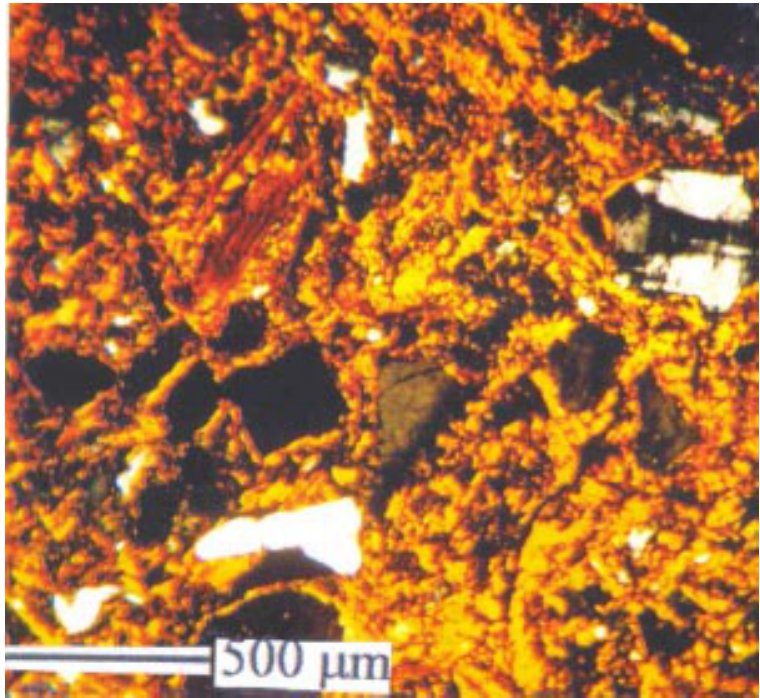
Figura 7. Micrografia do horizonte Bt do Brunizém Avermelhado. Aspecto da formação de argila in situ , tendo o plasma o padrão de extinção reticulado herdado da